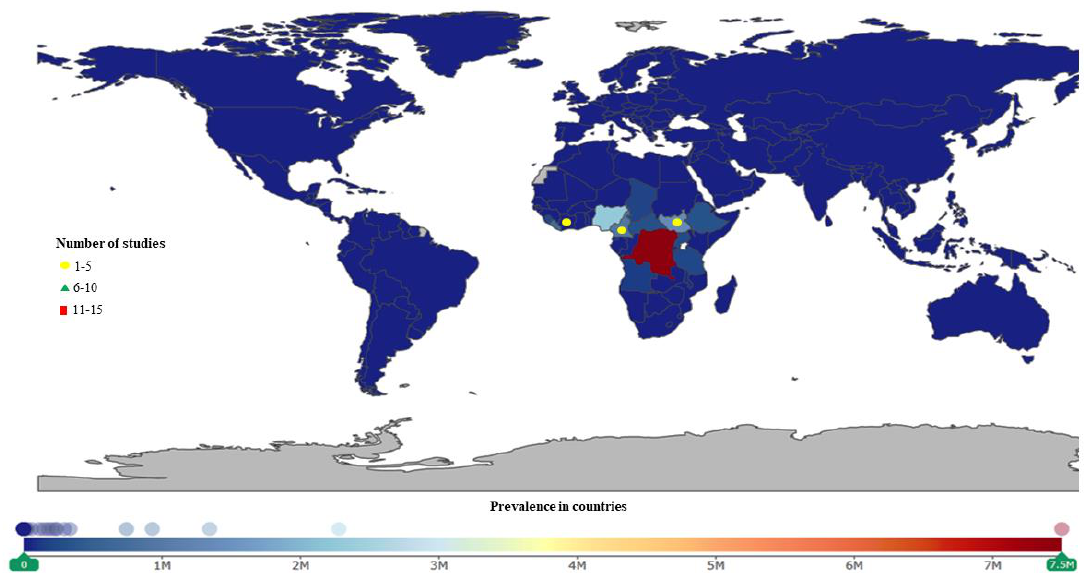
Figure 5. Soil-transmitted helminths studies were conducted more often in Africa. China, India, and Nigeria have the highest prevalence.